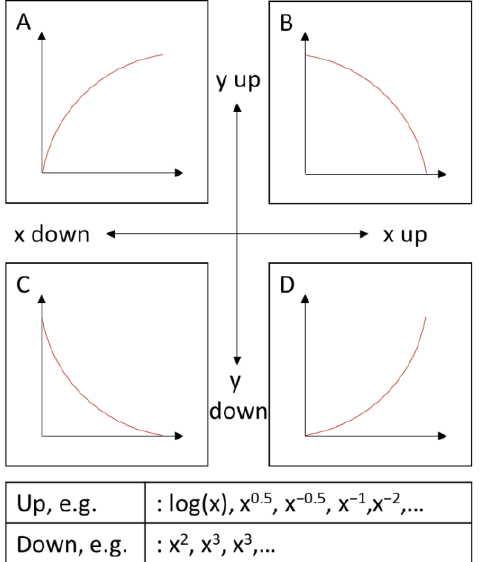
Figure 1. Latter of powers after Tukey [57]. Potentiation of x − and y − values for data linearization depending on the shape of the curve. A distinction is made between increasing ( A , D ) and decreasing ( B , C ) function values, and increasing ( B , D ) and decreasing ( A , C ) magnitude of slope.